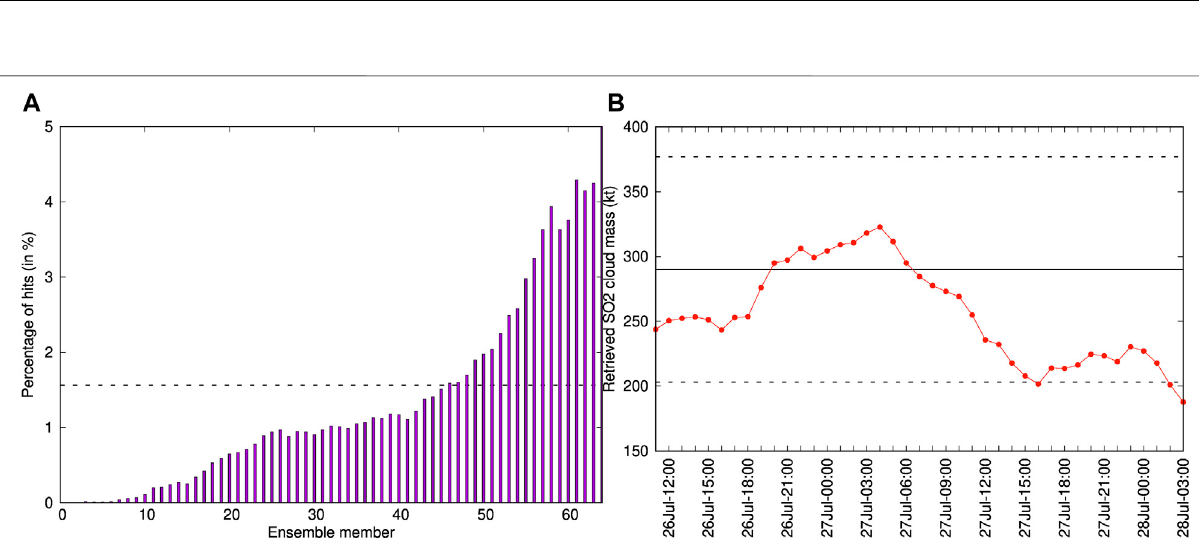
Frontiers in Earth Science |